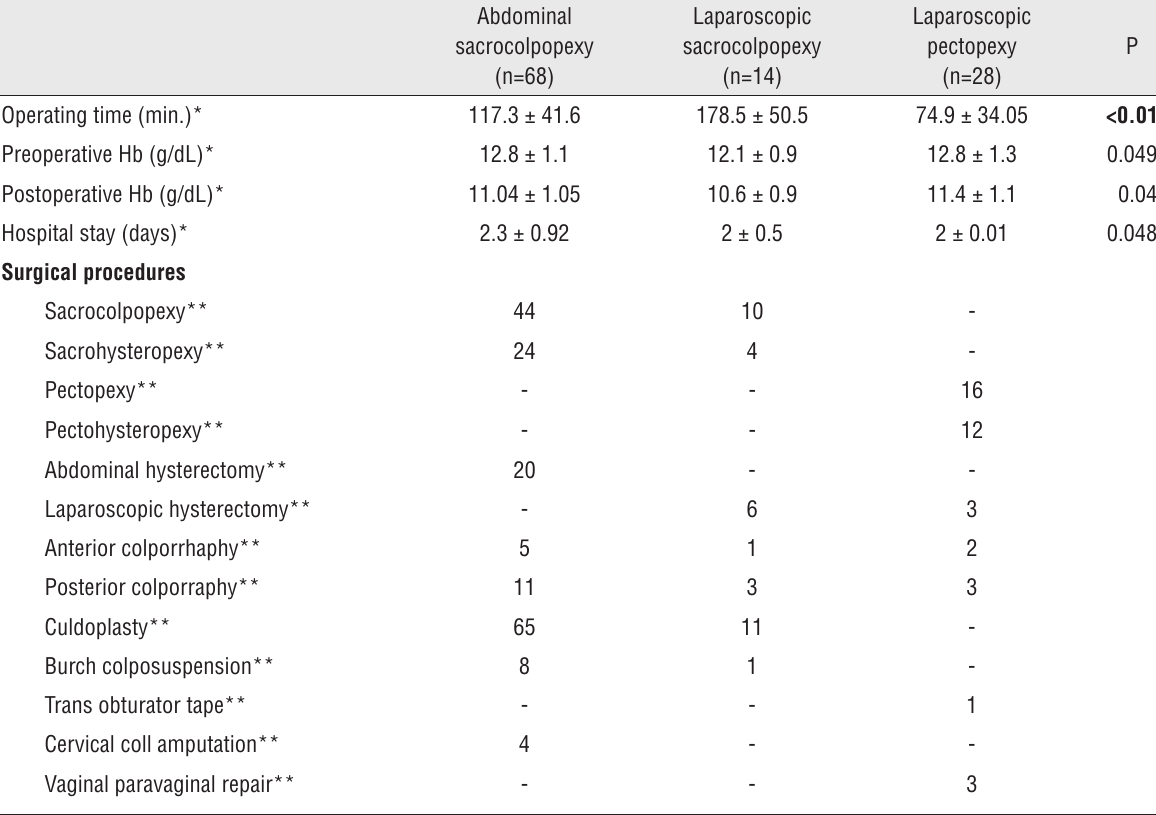
Table 2 - perioperative characteristics and performed surgical procedures in the study groups.